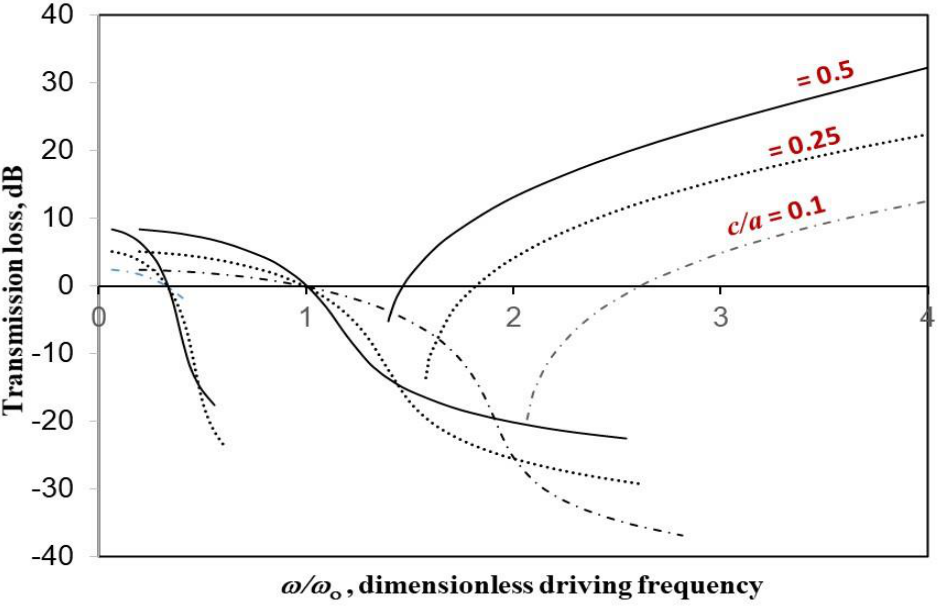
Figure 6. Transmission loss ratio versus excitation frequency for various cavity depths ( k = 5, ξ = 0.02, single cavity). Table 1. Vibration amplitude convergence for various driving frequencies and number of modes used ( c/a = 0.5, k = 10, ξ = 0).